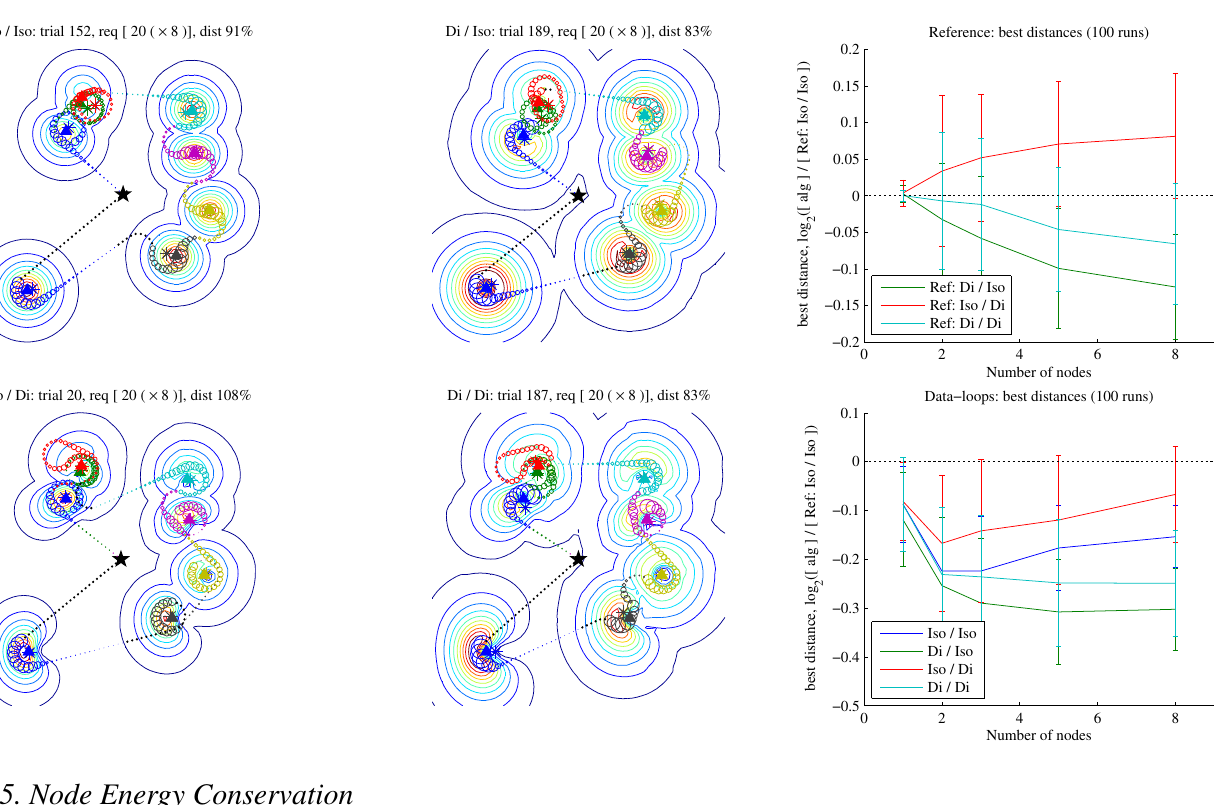
Figure 9. Effect of equipping the aircraft with a short dipole vs. isotropic antenna. The field plots show learned trajectories for a random field of 8 nodes (contours, as always, show what the aircraft would see in level flight, not what it actually sees as it turns and banks). Top Left: sample field for isotropic antennas on UA and nodes. Top Middle: dipole antenna on aircraft, isotropic antennas on nodes. Bottom Left: isotropic on aircraft, dipoles on nodes. Bottom Middle: dipoles all around. Top right: comparison of lengths of Reference trajectories for all conditions (named for antenna patterns on aircraft/nodes respectively) relative to the isotropic/isotropic case (shown as the zero), on a logarithmic scale. Bottom right: comparison of best learned trajectory lengths for the four combinations, compared to the same isotropic/isotropic reference used